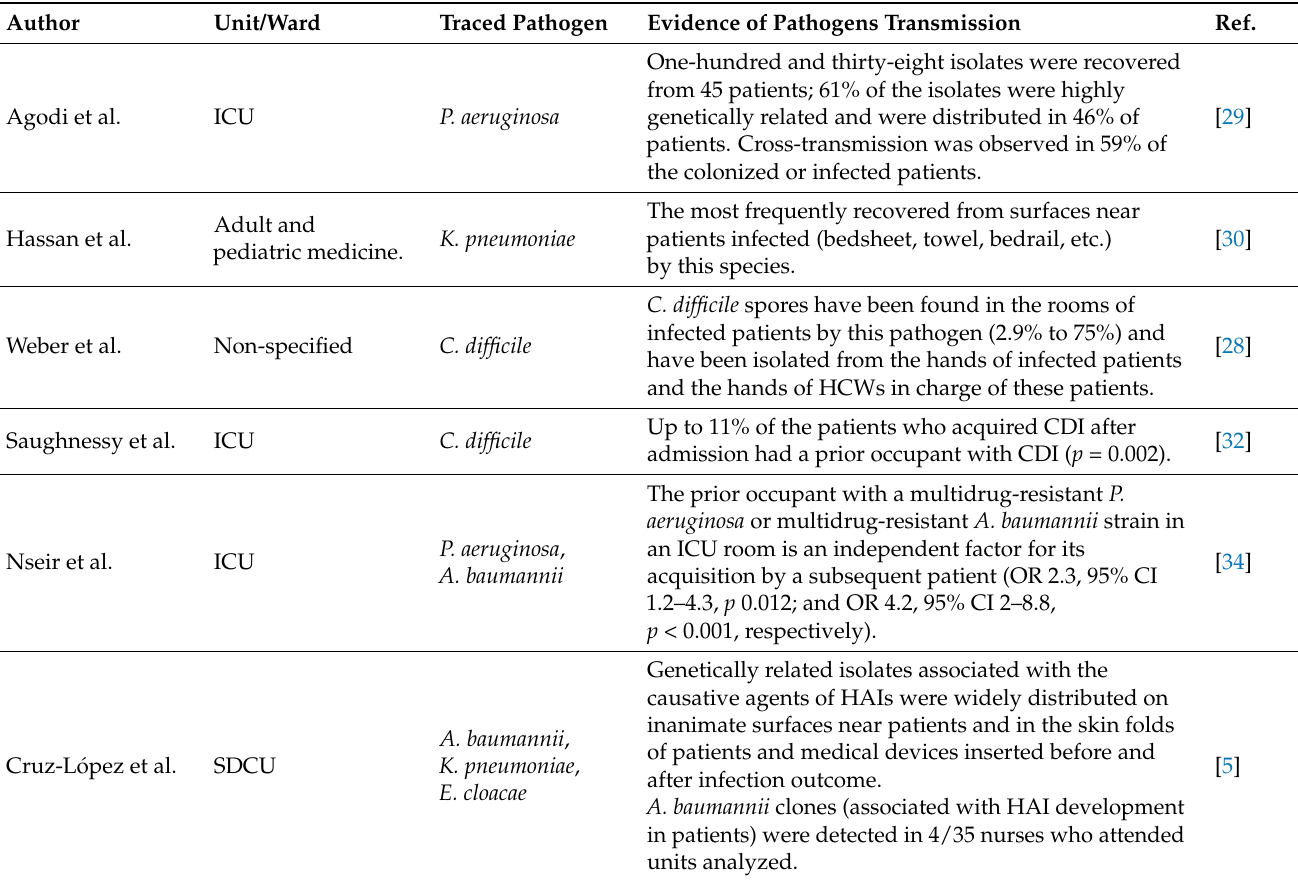
Table 2. Vectors of transmission in hospital